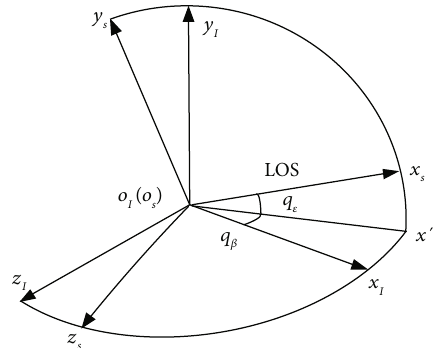
Figure 5: Relation between LOS angles and inertial reference system.